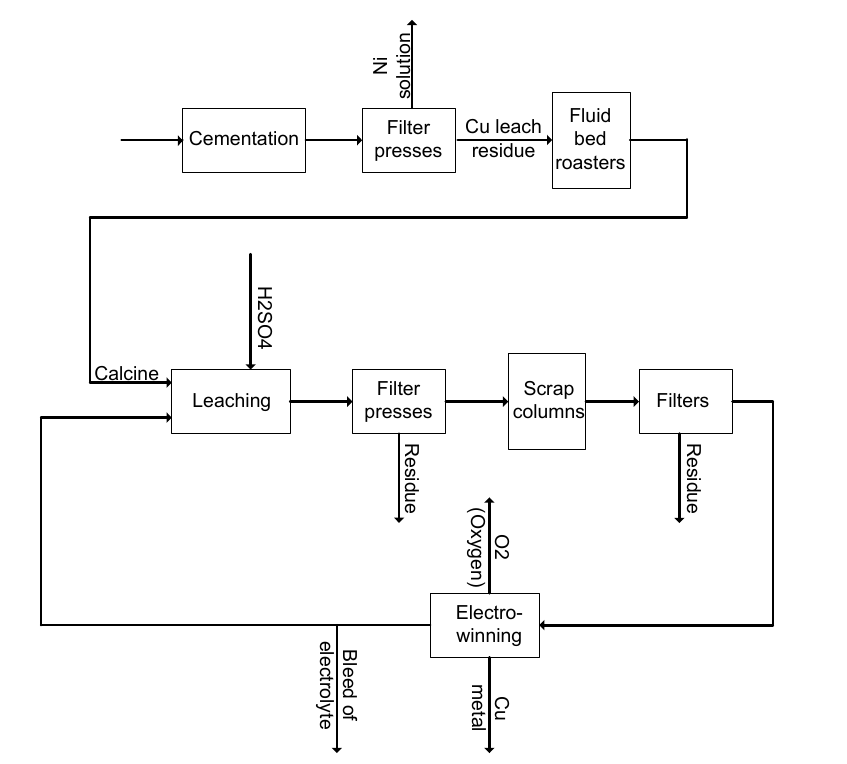
Figure 4: Overview of the Cu